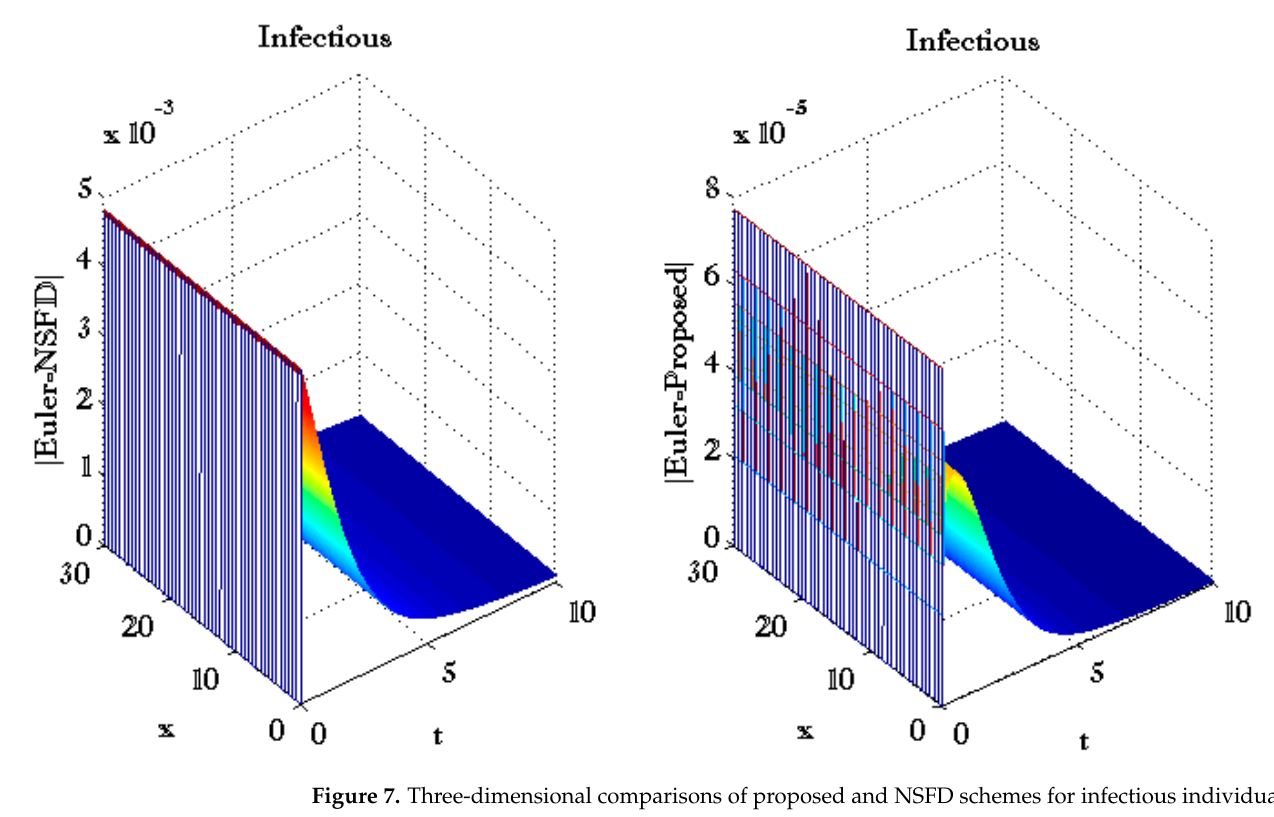
Figure 7. Three-dimensional comparisons of proposed and NSFD schemes for infectious individuals using N x = 50, N t = 1300, α 1 = 0.1, β = 0.1, γ = 0.3, σ = 0.4, µ = 0.5, d 1 = 2, d 2 = 2.5, d 3 = 2.5, d 4 = 2, d 5 = 2, α = 0.9.